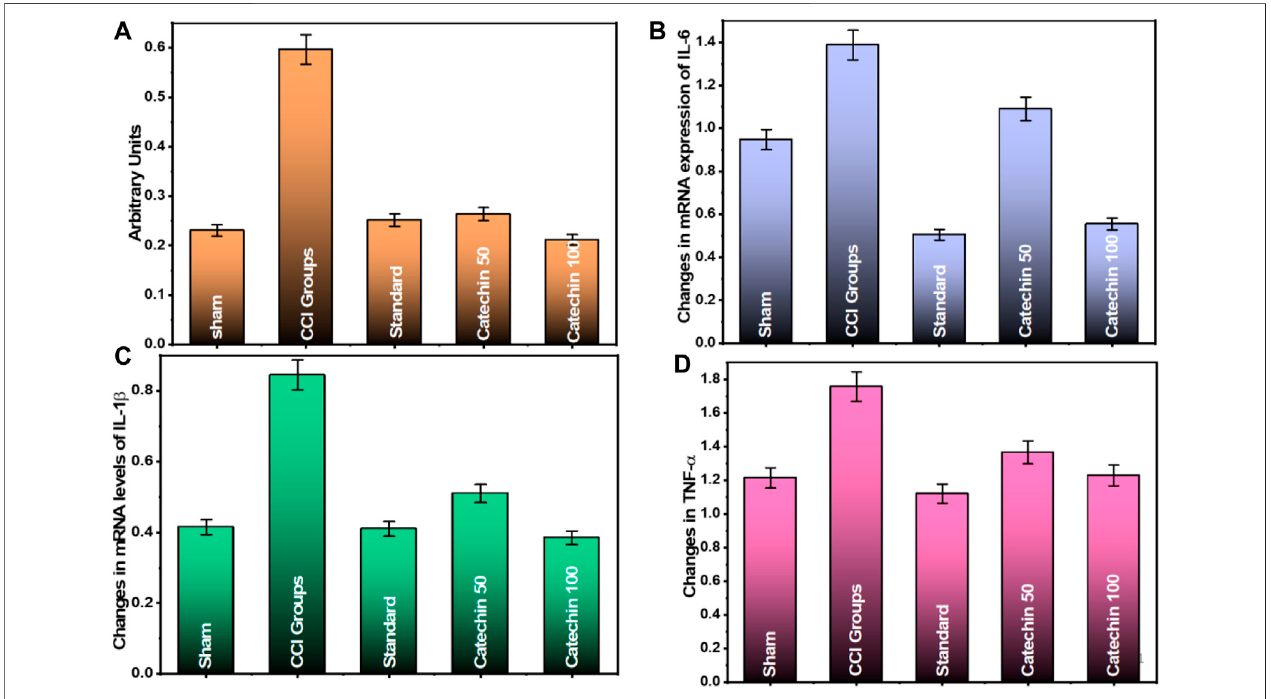
FIGURE 4 | Effect of catechin on (A) NF- κ B activation; (B) mRNA expression of IL-6; (C) mRNA expression of IL-1 β ; and (D) mRNA expression of TNF- α .